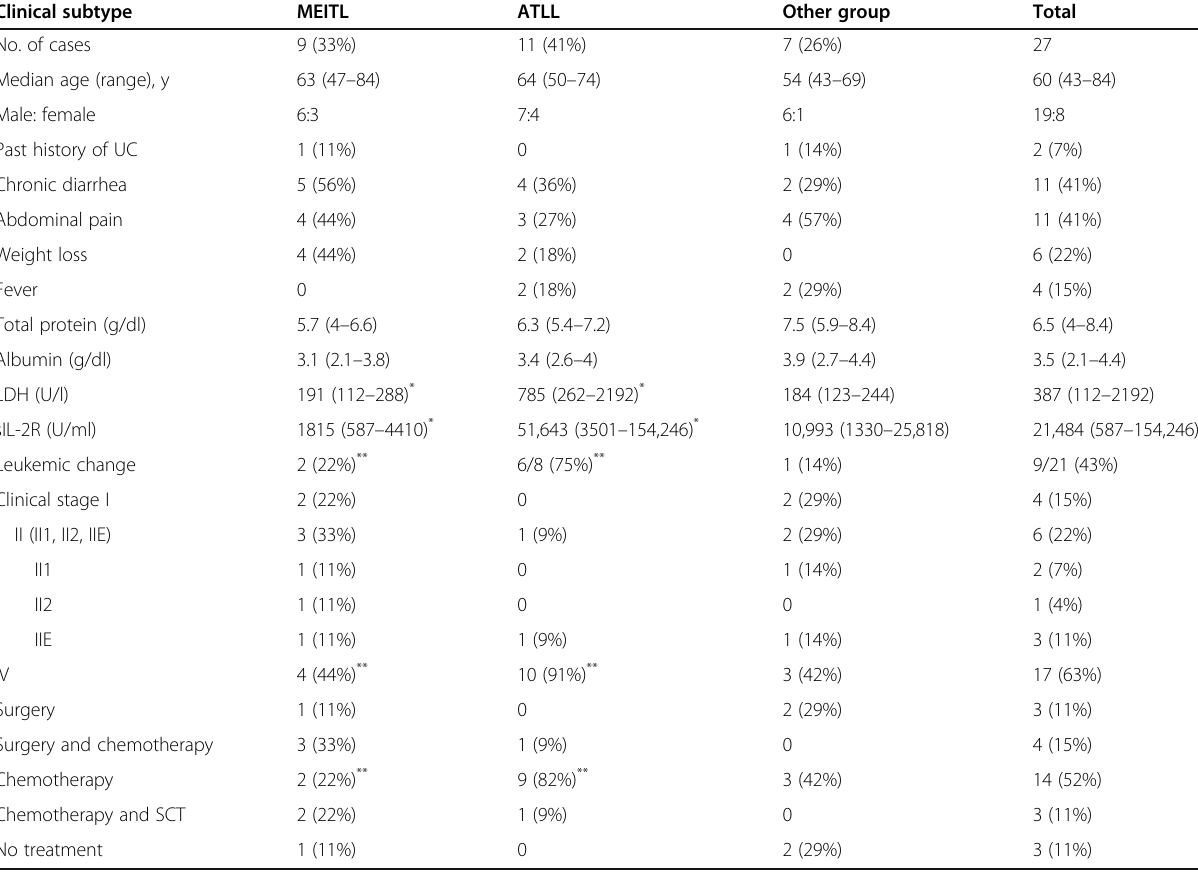
Table 1 Clinical findings and treatments of 27 colorectal T/NK cell lymphoma patients Clinical